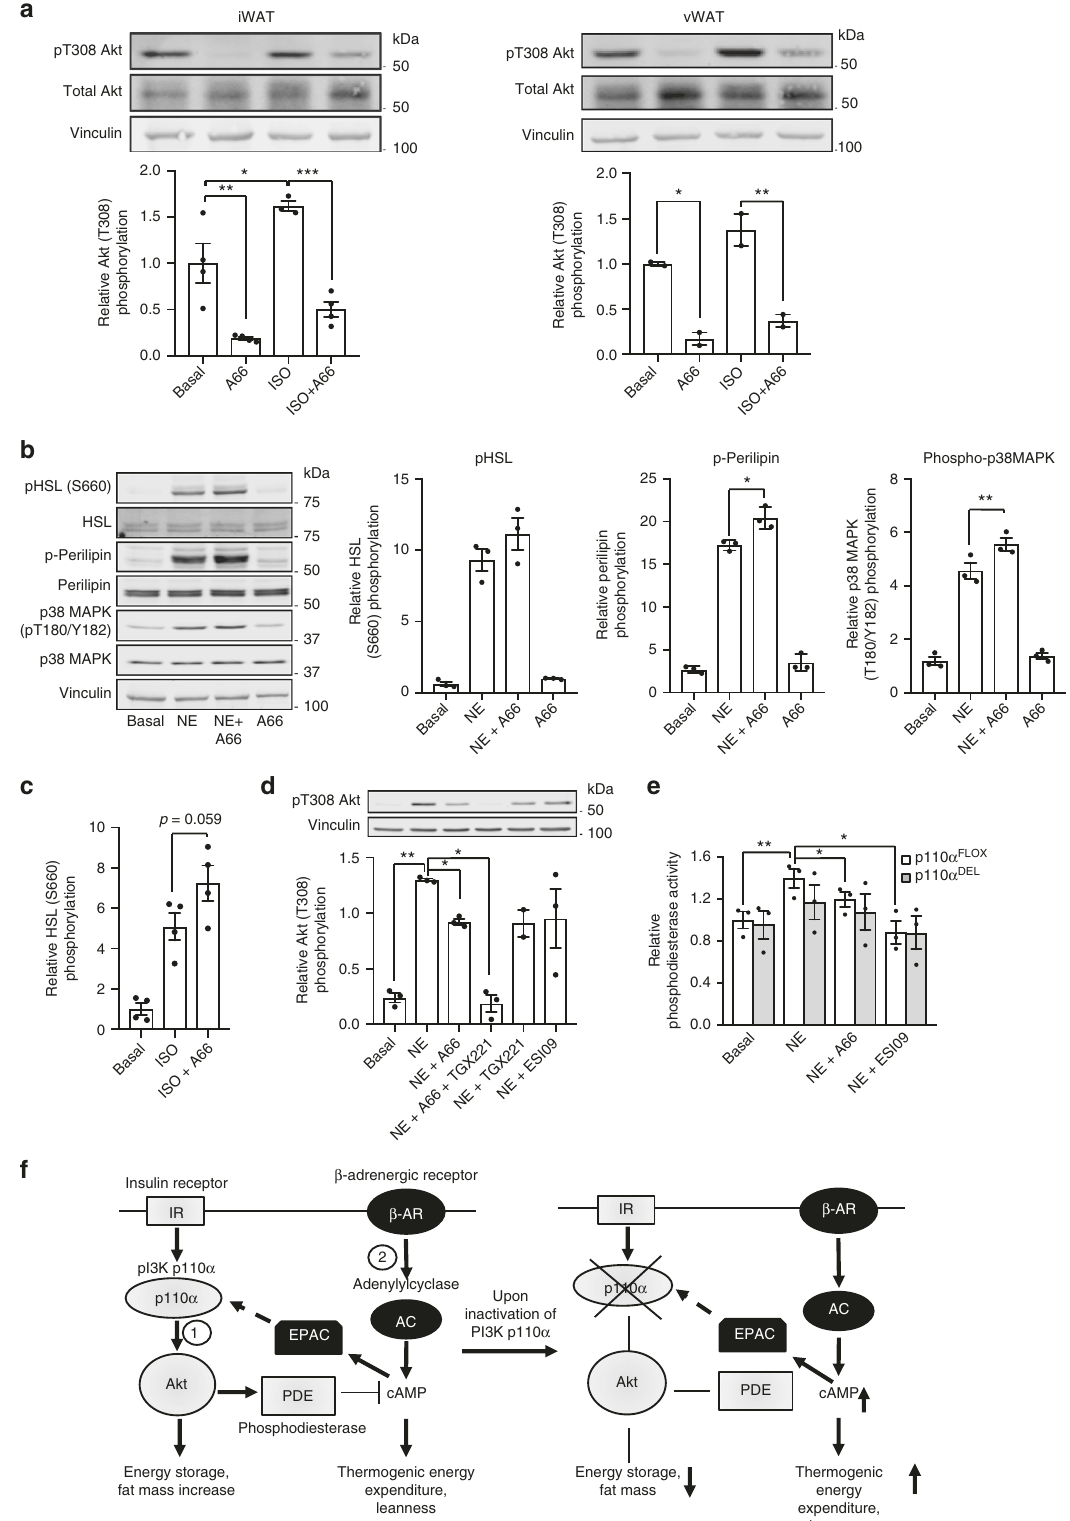
changes in body weight and therefore metabolic mass. These fi ndings are consistent with the enhanced β -adrenergic signalling in isolated adipose tissue explants from p110 α DEL mice (Fig. 4 and Supplementary Fig.